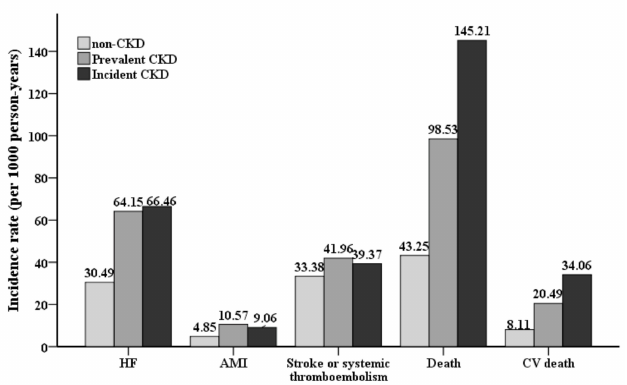
Figure 2. Cumulative incidence rate of study outcomes between prevalent CKD, non-CKD and incident CKD